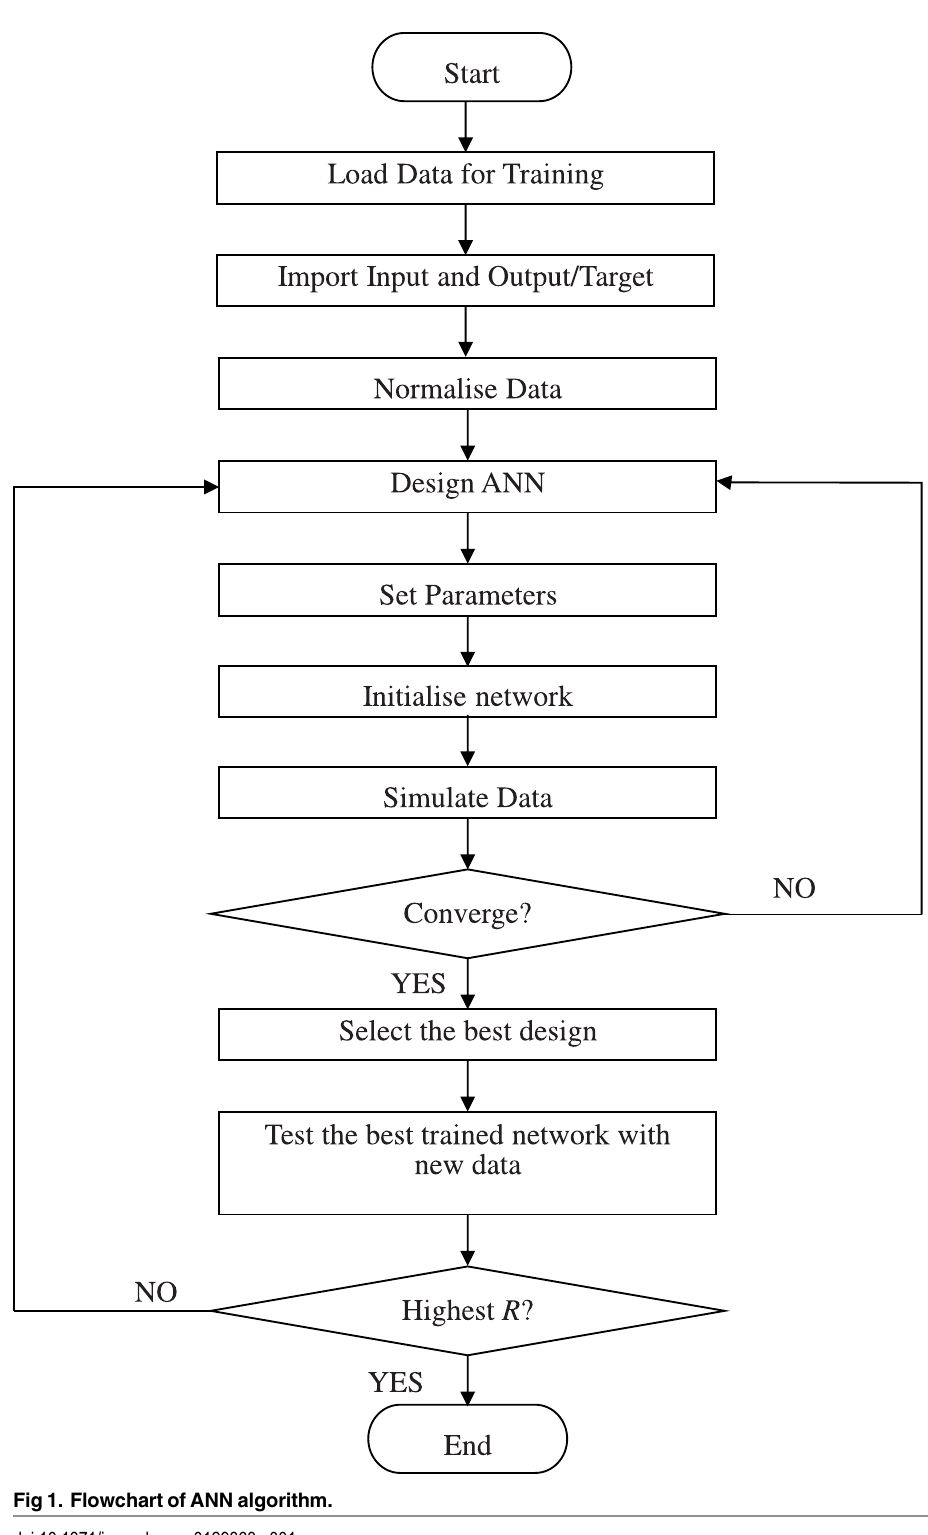
Fig 1. Flowchart of ANN